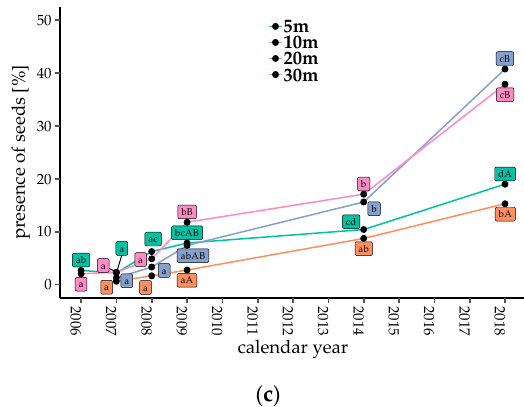
Figure 2. Temporal changes in seed dispersal of bird-dispersed woody species in each plot. ( a ) Number of dispersed seeds; ( b ) number of dispersed fruits; and ( c ) proportion of seed traps with dispersed seeds at each collection. Different lowercase letters denote significant differences among measuring years, and uppercase letters denote significant differences among plots from multiple comparisons (generalized linear model (GLM), α = 0.05).